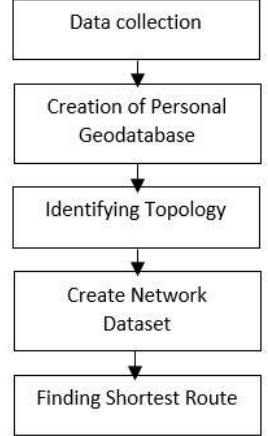
Figure 5 Flow for Network Analysis